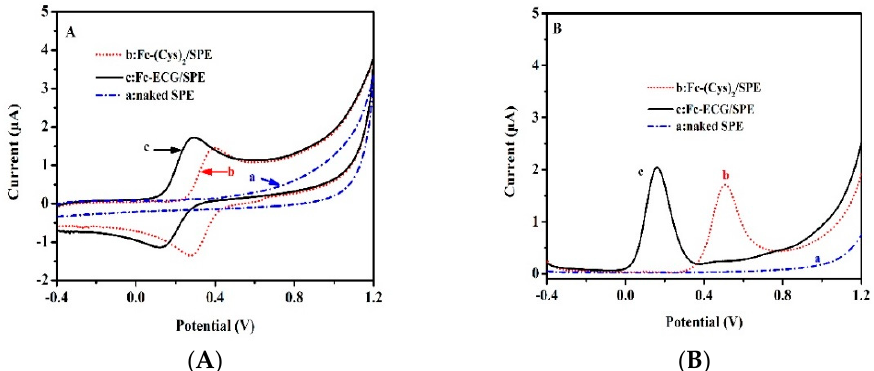
Figure 3. CV( A ) and DPV( B ) curves for different materials modified SPEs in 0.1 mol·L − 1 PBS (pH 7.0) Figure 3. CV ( A ) and DPV ( B ) curves for different materials modified SPEs in 0.1 mol · L − 1 PBS (pH 7.0) (a: naked SPE, b: Fc(Cys) 2 /SPE; c: Fc-ECG/SPE). (a: naked SPE, b: Fc(Cys) 2 /SPE; c: